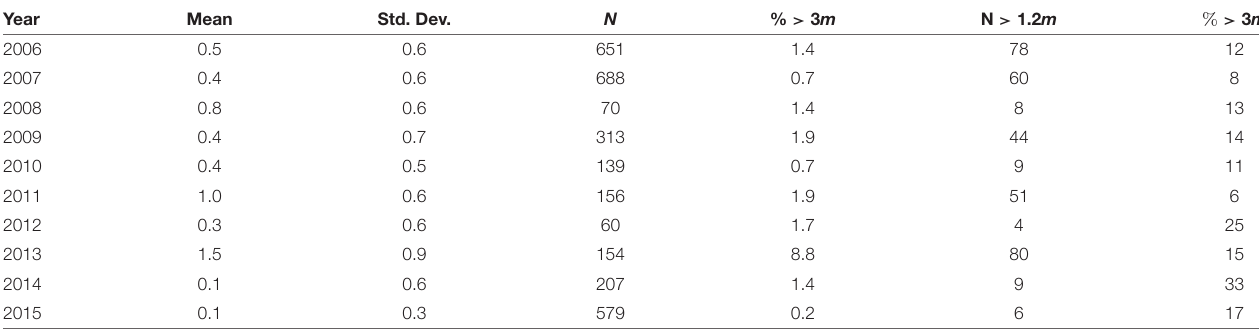
The standard deviation (Std. Dev.) and number of individual ridge observations (N) are recorded. The percentage of observations with mean sail height > 3m ( % > 3m ) is also shown. Column N > 1.2m shows the number of observations with sail heights greater than the Hibler (1975) threshold defining a ridge, and percentage of these that are > 3 m is shown in the right hand column.